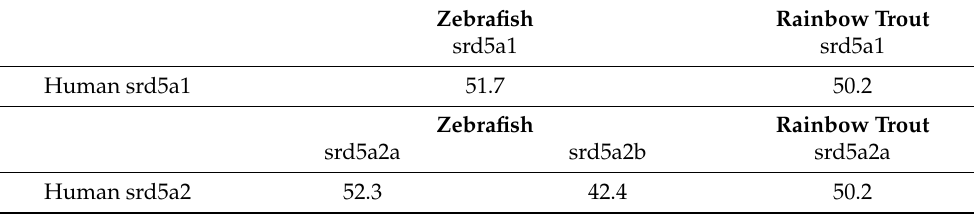
Table 4. Percentage of amino acid identity of human, zebrafish, and rainbow trout 5ARs. Zebrafish Rainbow Trout srd5a1 srd5a1 Human srd5a1 50.2 Zebrafish Rainbow Trout srd5a2a